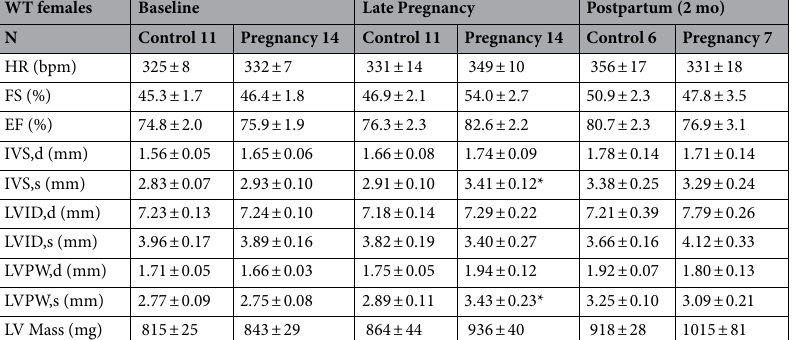
Table 1. Echocardiography parameters in WT females from control and pregnancy groups. Measurements were performed at baseline, during late pregnancy and two months after giving birth. HR heart rate, bpm beats per minute, FS fractional shortening, EF ejection fraction, IVS,d and IVS,s thickness of interventricular septum in diastole and systole, respectively, LVID,d and LVID,s left-ventricular internal diameter in diastole and systole, respectively, LVPW,d and LVPW,s thickness of left-ventricular posterior wall in diastole and systole, respectively. * P < 0.05 vs. control